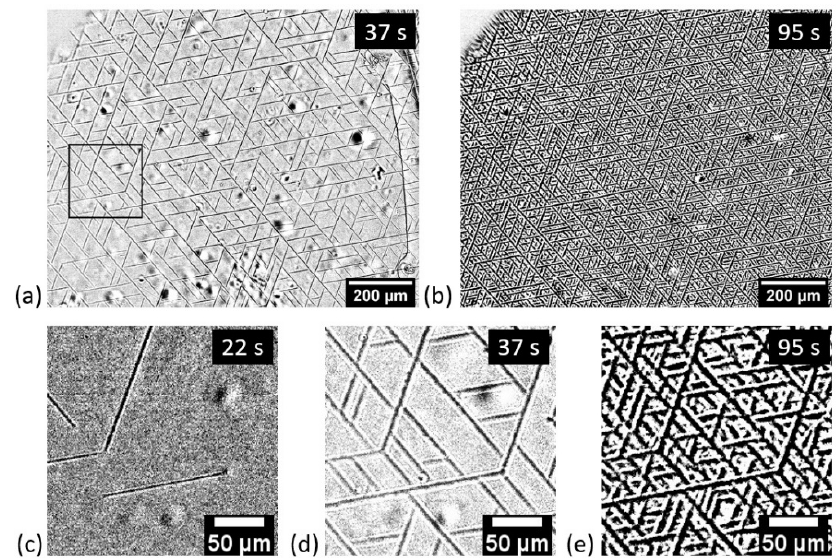
Figure 3. Instantaneous optical images of the domain structure during polarization switching in increasing field. ( a , b ) At the time interval from the start of field pulse application: ( a ) 37 s (E = 8 kV/mm), ( b ) 95 s (E = 19 kV/mm). ( c – e ) Magnified fragment of the images marked in ( a ), at the time interval: ( c ) 22 s (E = 4.5 kV/mm), ( d ) 37 s (E = 8 kV/mm), ( e ) 95 s (E = 19 kV/mm). The field growth rate is 0.2 kV/(mm s).